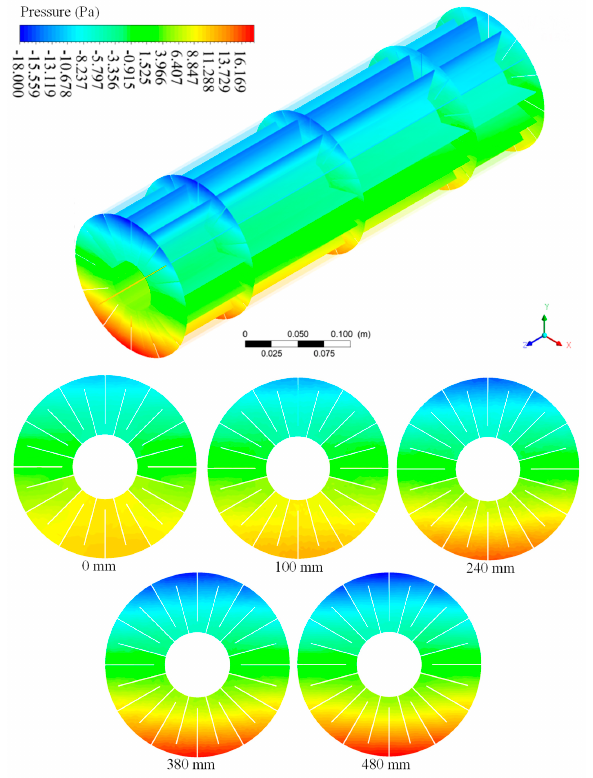
Figure 21. Pressure distribution in the PCM domain for 10% (t = 10,293 s) of its volume in a liquid state. 3.2.5. Velocity in the PCM In Figures 22 to 25, we have the velocities developed in the PCM due to the buoyancy forces promoted in the material structure due to the density variations that resulted from the cooling process. The PCM started the solidification process when it was in a totally liquid state, with velocities in the order of 10-4 m/s. As the material had its temperature reduced, the density increased under the action of gravitational force, which was con- verted into displacements that varied according to the degree of material solidification. These displacements caused the heat transfer process to occur by natural convection in addition to thermal diffusion.